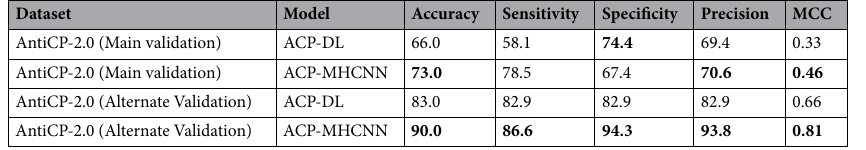
Table 11. Comparing the results achieved for ACP-MHCNN to ACP-DL as the state-of-the-art anticancer peptide predictor. Bold items indicate the best values found by the methods.